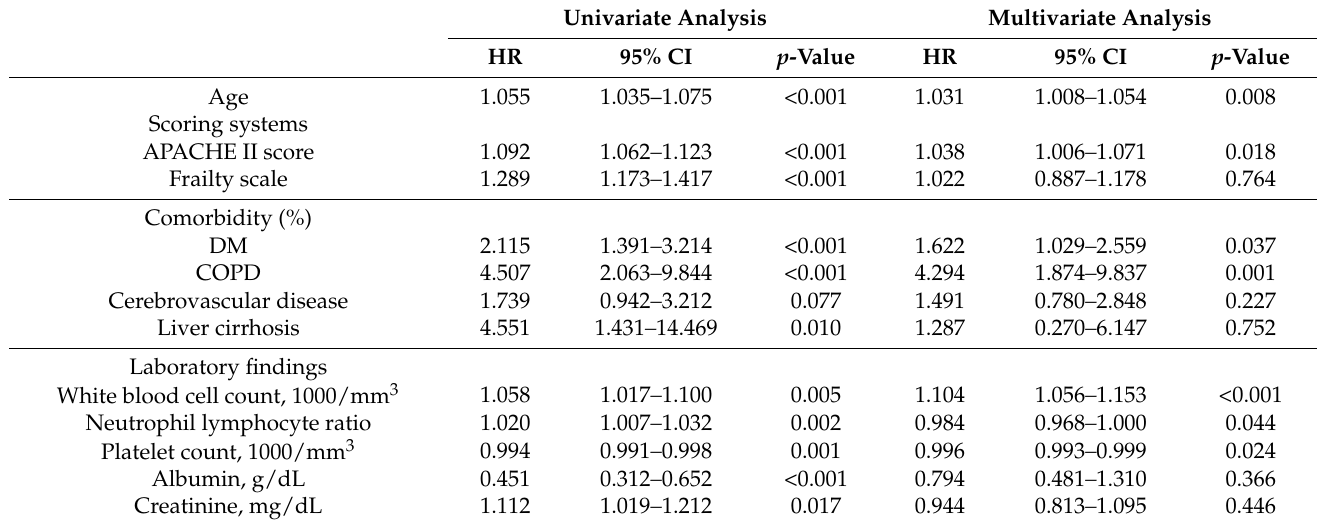
Table 3. Univariate and multivariate risk factors associated with in hospital mortality (Cox regression